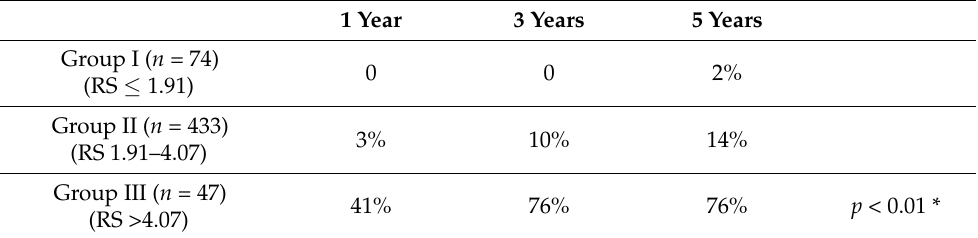
Table 6. Real cumulative incidence of mortality in derivation set based on range of risk score (RS).